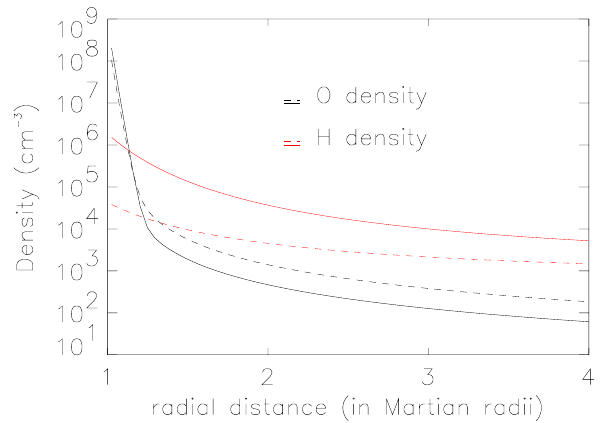
Fig. 1. Neutral hydrogen and oxygen coronae at solar minimum and solar maximum. Solid curves represent the densities during solar minimum while dashed curves correspond to the solar maximum conditions.